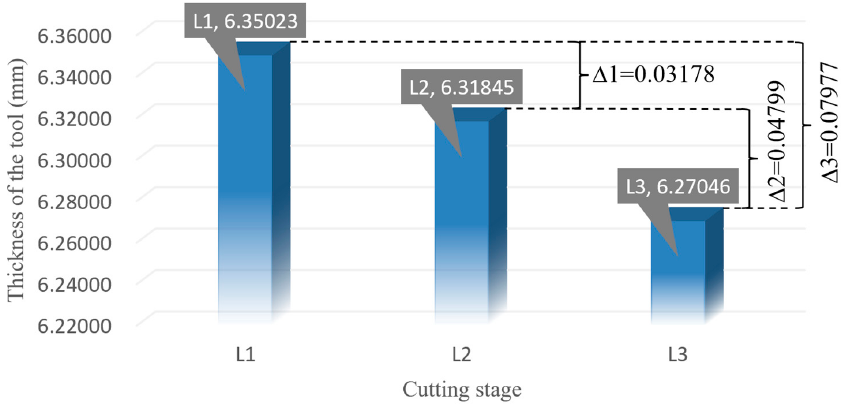
Figure 14. Variation in tool thickness in the near-field of the CCMTT in different stages.